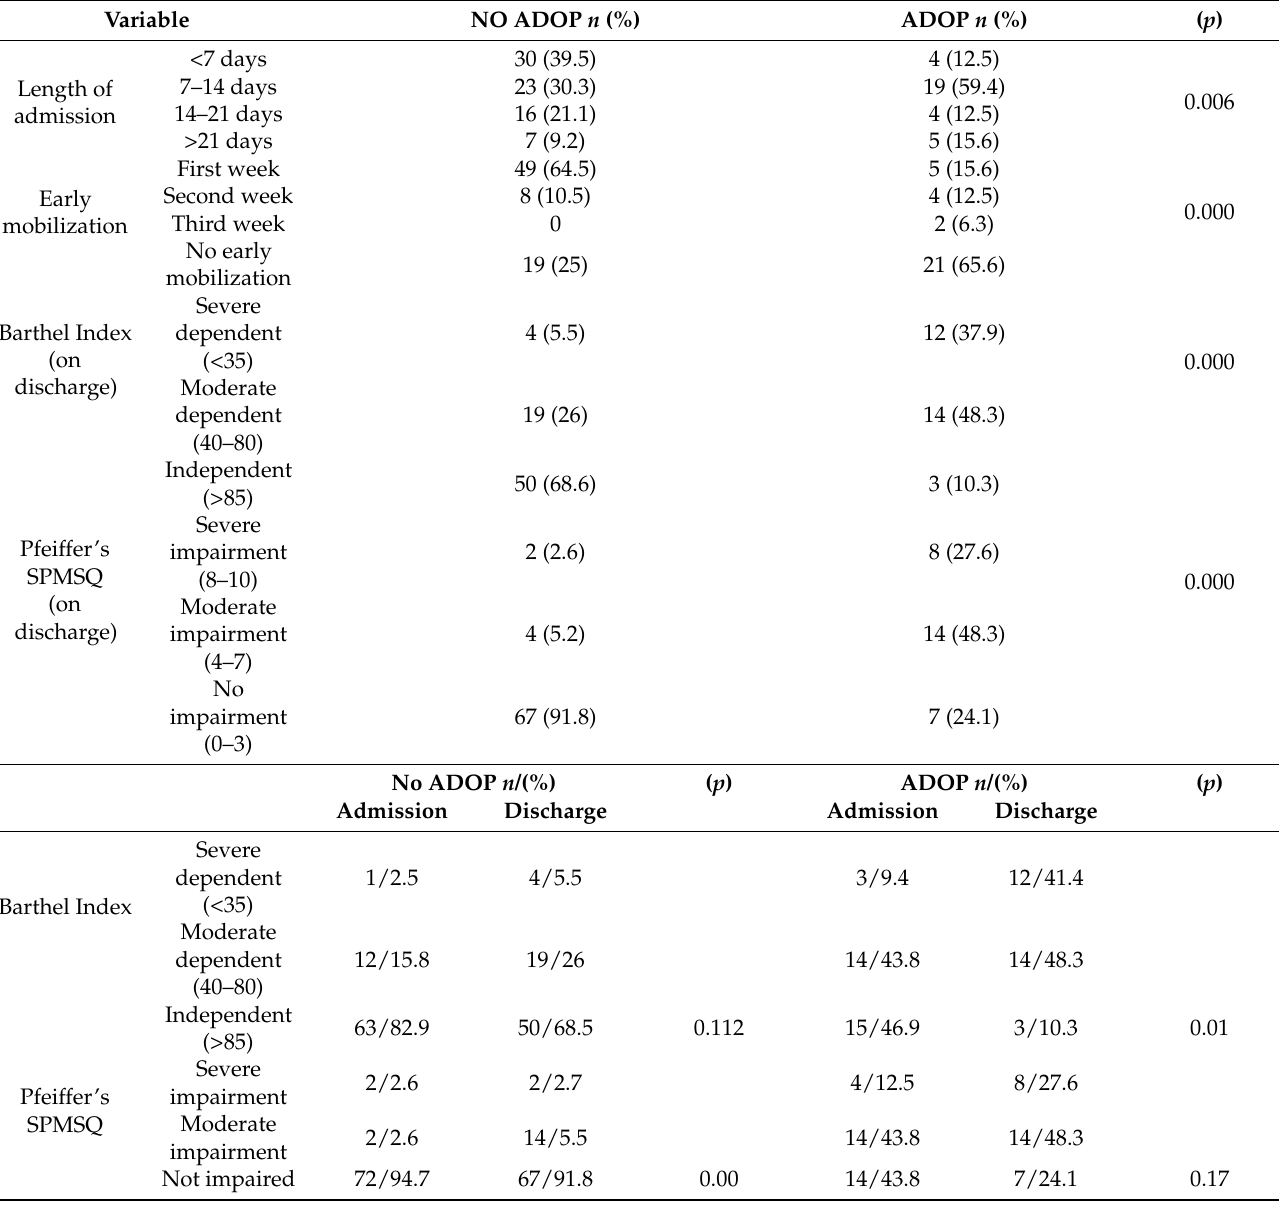
Table 5. Patients’ clinical progression during hospital